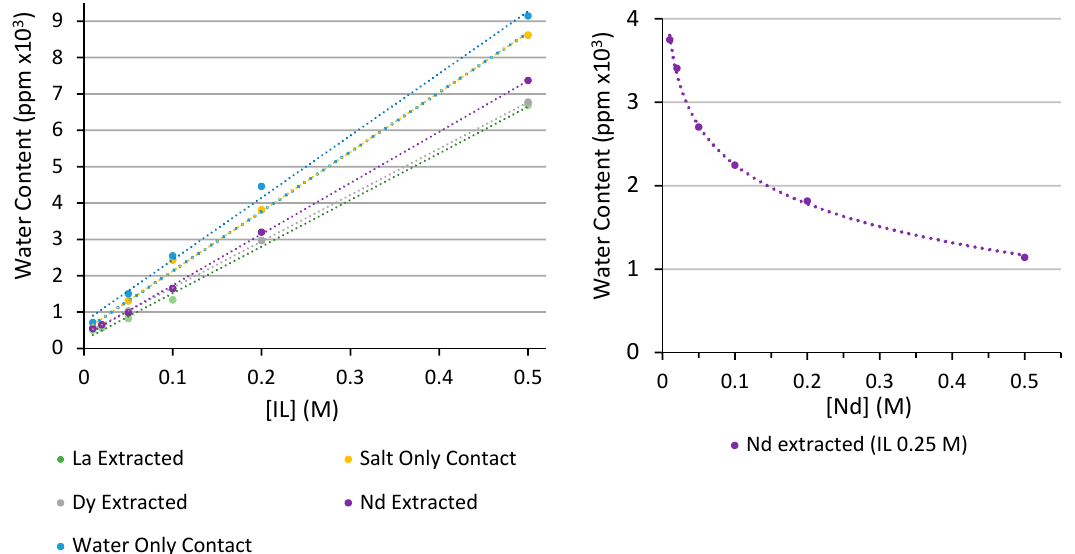
Figure 4. ( Left ): the water content (ppm) of IL (0.01–1.00 M) organic phases determined by Karl-Fischer titration. ( Right ): the water content (ppm) of organic phase IL (0.25 M) with varying Nd (0.01–0.5 M) was also determined by Karl-Fischer titration. Interpolation used to aid the eye only.